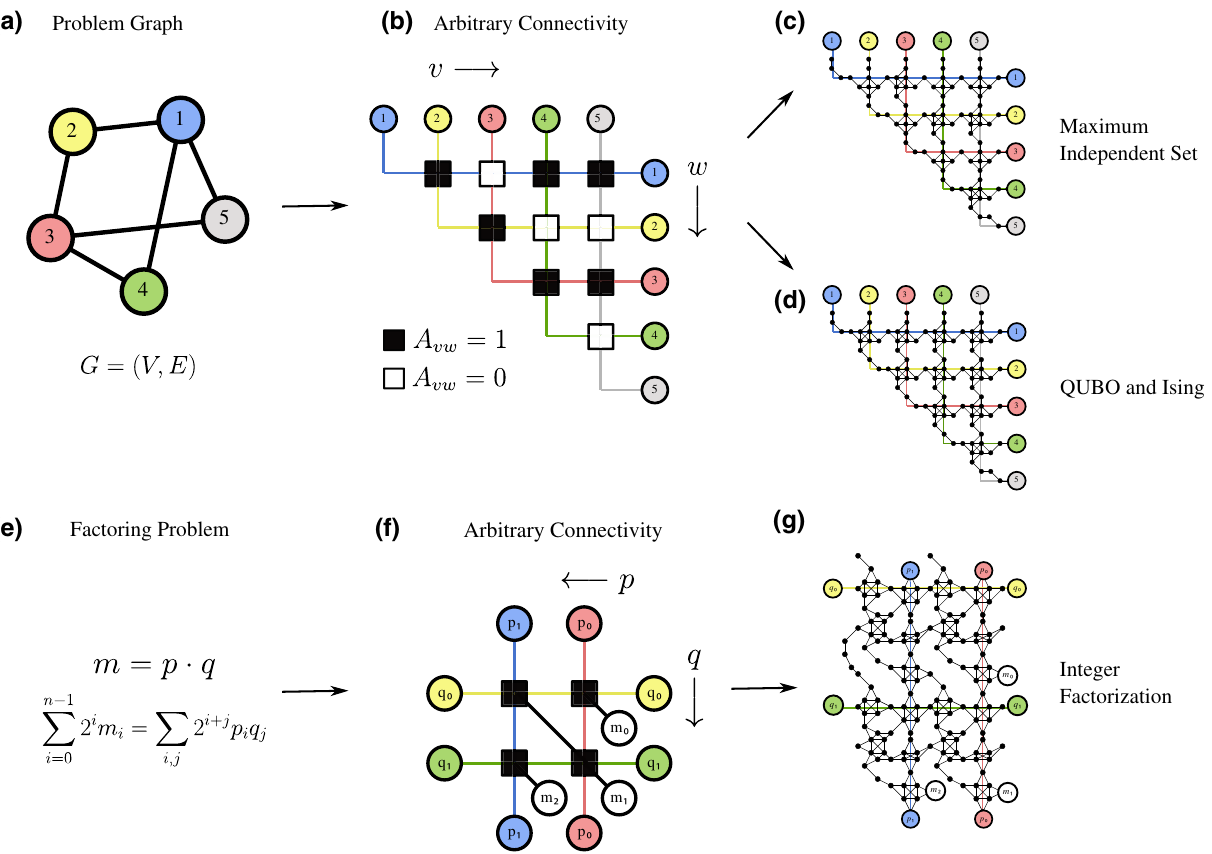
FIG. 2. Architecture of UDG-MWIS mapping for three example problems. (a) Example non-UDG represented by G = ( V , E ) for the MWIS and QUBO problems. (b) Crossing lattice used to construct UDG-MWIS mappings. Vertices in (a) are binary variables that can be represented effectively by lines to construct the lattice. Intersections in the lattice allow arbitrary connectivity between the variables, abstractly represented by squares. The lattice mimics an upper triangular adjacency matrix A , where for two vertices { v , w } ∈ V , A v w = 1 if (v , w ) ∈ E and A v w = 0 otherwise, represented abstractly by a filled and empty square here, respectively. (c) Final UDG- MWIS representation of the original MWIS problem on general graphs. (d) Final UDG-MWIS representation of the original QUBO and Ising problem. (e),(f),(g) Similar encoding procedure for the integer factorization problem for the example 6 = 2 × 3, with the corresponding UDG-MWIS representation shown in